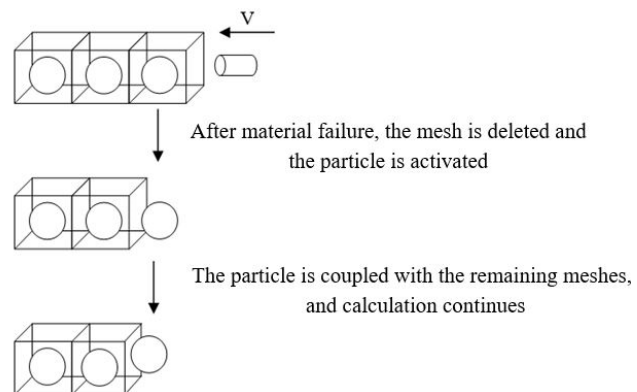
Figure 3. Process of finite element method-smooth particle hydrodynamics adaptive coupling method.